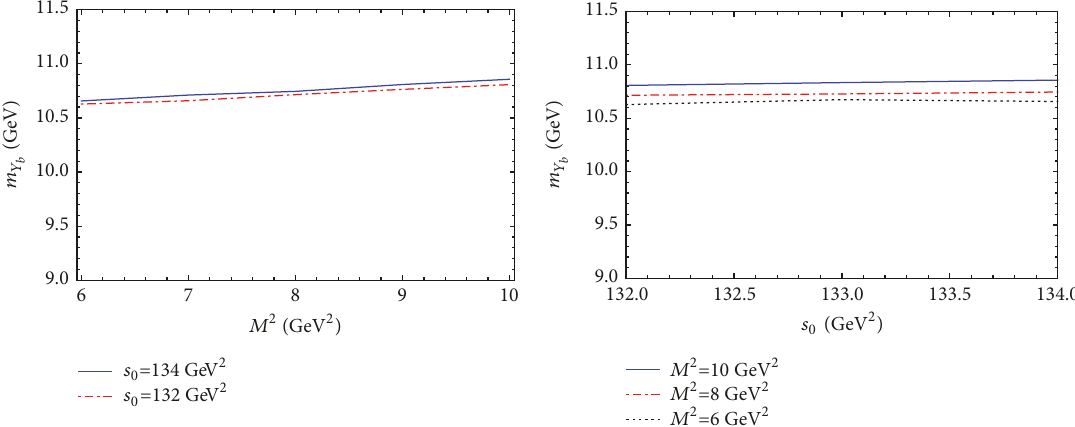
Figure 2: Mass of 𝑌 푏 as a function of 𝑀 2 (left) and 𝑠 0 (right).